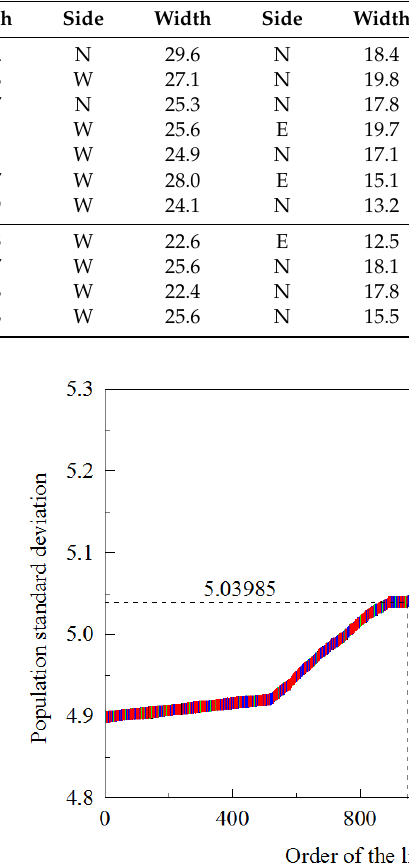
Table 1. The maximum (max.) edge width (km), the side of the landscape on which it occurred, and ISPRS Int. J. Geo-Inf. 2019 , 7 , x FOR PEER REVIEW the length-weighted mean edge width of the whole grid-level fire frequency (GFF) map. The 11 GFF N maps di ff er in number (N) of fire-year maps. The three methods compared are moving windows (MWs), agglomeration of inner lines (AILs), and removal of outer lines (ROLs). MW Max. GFF N